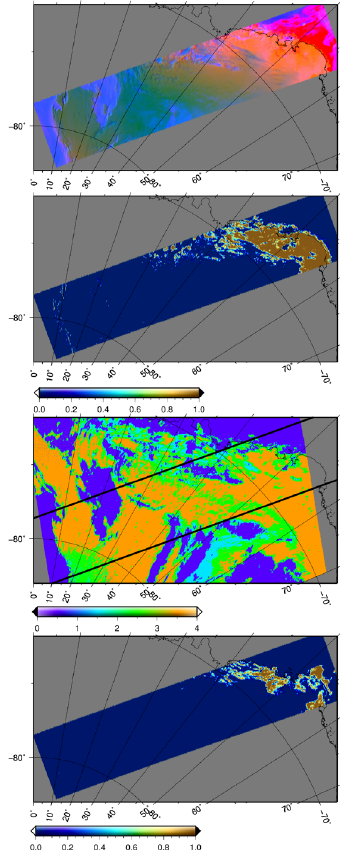
Fig. 15. Antarctica, AATSR: 20 January 2006, 5h 16min 00s, or- bit number 20341. MODIS: 20 January 2006, 5h 00min. Top panel is the false colour composite (red is 11µm BT, green is 550nm re- flectance, blue is 1.6µm reflectance) of initial AATSR scene; sec- ond from top panel is the clear snow mask of AATSR scene (0 – not snow, 1 – clear snow) achieved with presented method; third from top panel is MODIS cloud mask: 1 – cloudy, 2 – probably cloudy, 3 – probably clear, 4 – clear; lowest panel is operational AATSR cloud mask from level-1b product: 0 – cloudy, 1 –